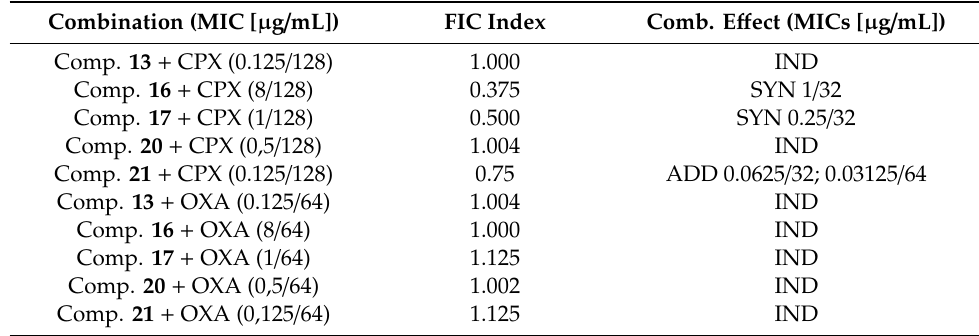
Table 2. E ff ect of tested compounds in combination with ciprofloxacin (CPX) and oxacillin (OXA) against isolate MRSA SA 630. MICs ( µ g / mL) of compounds alone and observed in the synergy experiment are shown in parentheses. In the case of additivity and synergy, concentrations of tested compound / CPX ( µ g / mL) providing this e ff ect are